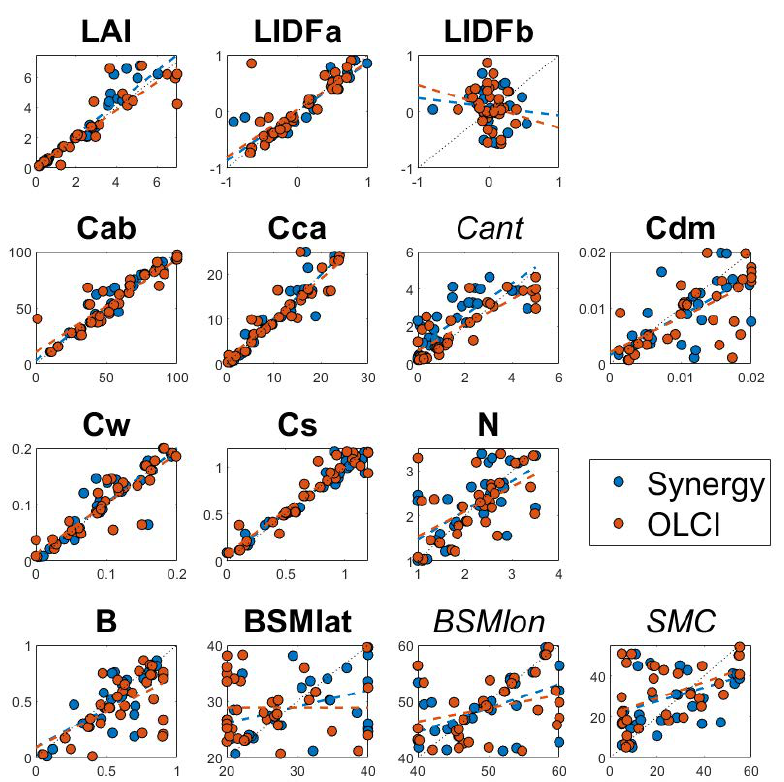
Figure 7. Quality of retrieval on a synthetic dataset. Parameters with names in italic (Cant, BSMlon, SMC)—parameters with low sensitivity index values. Top—canopy parameters, middle—leaf parameters, bottom—soil parameters. Red - retrieval from OLCI bands, blue - retrieval from both OLCI and SLSTR (Synergy) bands. Definitions of parameters can be found in Table